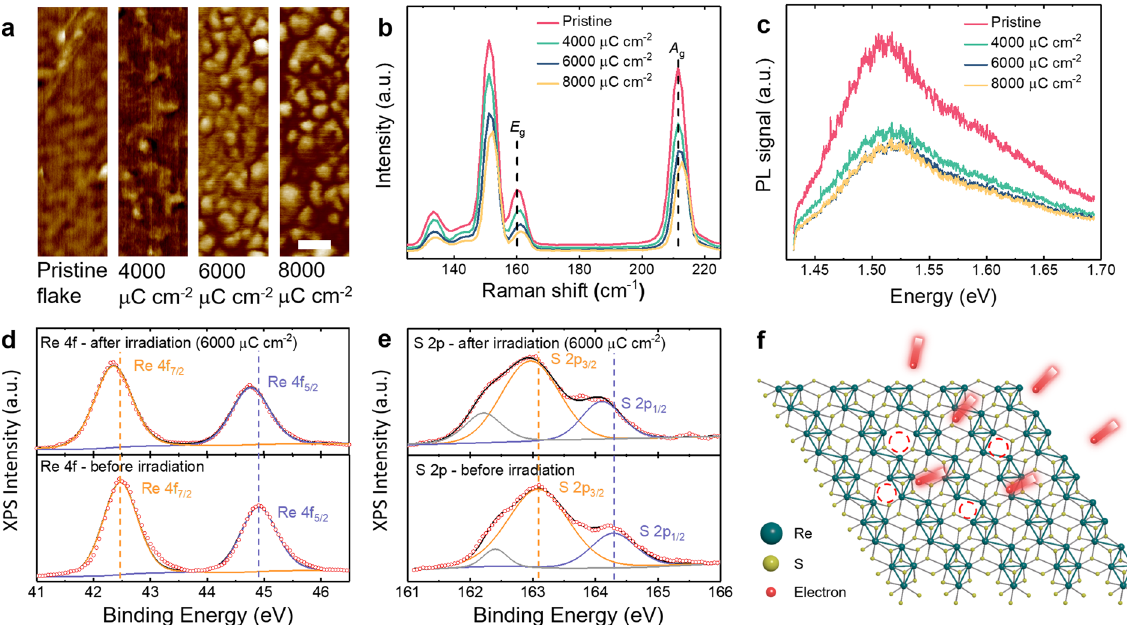
Fig. 2 Characterization of electron-beam-irradiated ReS 2 . a AFM phase images taken with different EBI dosages. Scale bar, 50 nm. b Raman spectra of ReS 2 with different EBI dosages. The dashed lines label the blue shift of E g and A g peaks. c PL spectra of ReS 2 fl ake with different dosages. d , e XPS signal of Re 4f and S 2p peaks before and after EBI with a dosage of 6000 μ C cm − 2 , respectively. The dashed lines label the peak position shift in XPS signal. f A schematic illustration of as-created sulfur vacancies during